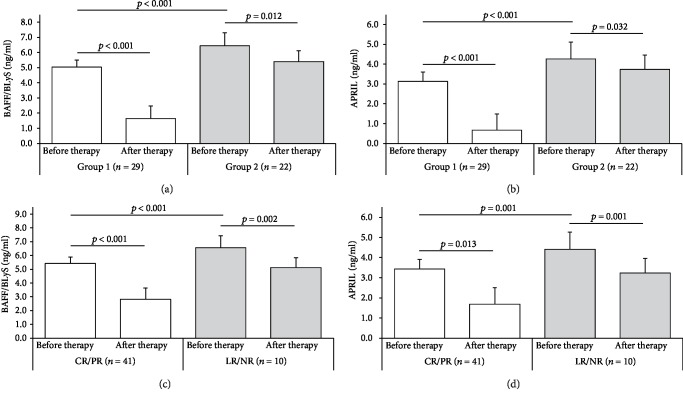
BAFF/BLyS and APRIL serum levels before and after 6-month immunosuppressive therapy among groups. (a) Baseline serum levels of BAFF/BLyS were significantly lower in group 1 (anti-PLA2R clearance after 6-month therapy, n = 29) as compared to group 2 (anti-PLA2R persistence after 6-month therapy, n = 22) (5.03 ± 0.48 vs. 6.44 ± 0.86 ng/mL, p < 0.001). If compared with BAFF/BLyS serum levels after 6-month therapy, really a significant reduction was observed mainly in group 1 (5.03 ± 0.48 vs. 1.64 ± 0.82 ng/mL, p < 0.001, white histograms), while in group 2, this reduction, though significant, was less pronounced (6.44 ± 0.86 vs. 5.39 ± 0.73 ng/mL, p = 0.012, gray histograms). (b) Baseline serum levels of APRIL were significantly lower in group 1 (anti-PLA2R clearance after 6-month therapy, n = 29) as compared to group 2 (anti-PLA2R persistence after 6-month therapy, n = 22) (3.12 ± 0.61 vs. 4.26 ± 0.63 ng/mL, p = 0.001). If compared with APRIL serum levels after 6-month therapy, really a significant reduction was observed mainly in group 1 (3.12 ± 0.61 vs. 0.67 ± 0.50 ng/mL, p < 0.001, white histograms), while in group 2, this reduction, though significant, was less pronounced (4.26 ± 0.63 vs. 3.72 ± 0.63 ng/mL, p = 0.032, gray histograms). (c) Baseline serum levels of BAFF/BLyS were significantly lower in PMN patients who achieved complete or partial remission (CR/PR, n = 41) after 24-month follow-up, as compared with those with limited response or nonresponders (LR/NR, n = 10) (5.41 ± 0.92 vs. 6.56 ± 0.52 ng/mL, p < 0.001). Moreover, if the BAFF/BLyS baseline serum levels were compared to those assessed after 6-month follow-up, the cytokine reduction was more marked in patients who achieved the best clinical outcome (CR/PR) after 24-month follow-up (5.41 ± 0.92 vs. 2.81 ± 1.82 ng/mL, p < 0.001, white histograms), as compared with the other group (LR/NR) (6.56 ± 0.52 vs. 5.11 ± 1.87 ng/mL, p = 0.013, gray histograms). (d) Baseline serum levels of APRIL were significantly lower in PMN patients who achieved complete or partial remission (CR/PR, n = 41) after 24-month follow-up, as compared with those with limited response or nonresponders (LR/NR, n = 10) (3.43 ± 0.80 vs. 4.41 ± 0.39 ng/mL, p = 0.001). Moreover, if the APRIL baseline serum levels were compared to those assessed after 6-month follow-up, the cytokine reduction was more marked in patients who achieved the best clinical outcome (CR/PR) after 24-month follow-up (3.43 ± 0.80 vs. 1.69 ± 1.58 ng/mL, p = 0.002, white histograms), as compared with the other group (LR/NR) (4.41 ± 0.39 vs. 3.23 ± 1.25 ng/mL for APRIL, p = 0.001, gray histograms). Mann-Whitney U test for nonparametric data. Data in the graphs are expressed as mean ± standard deviation.